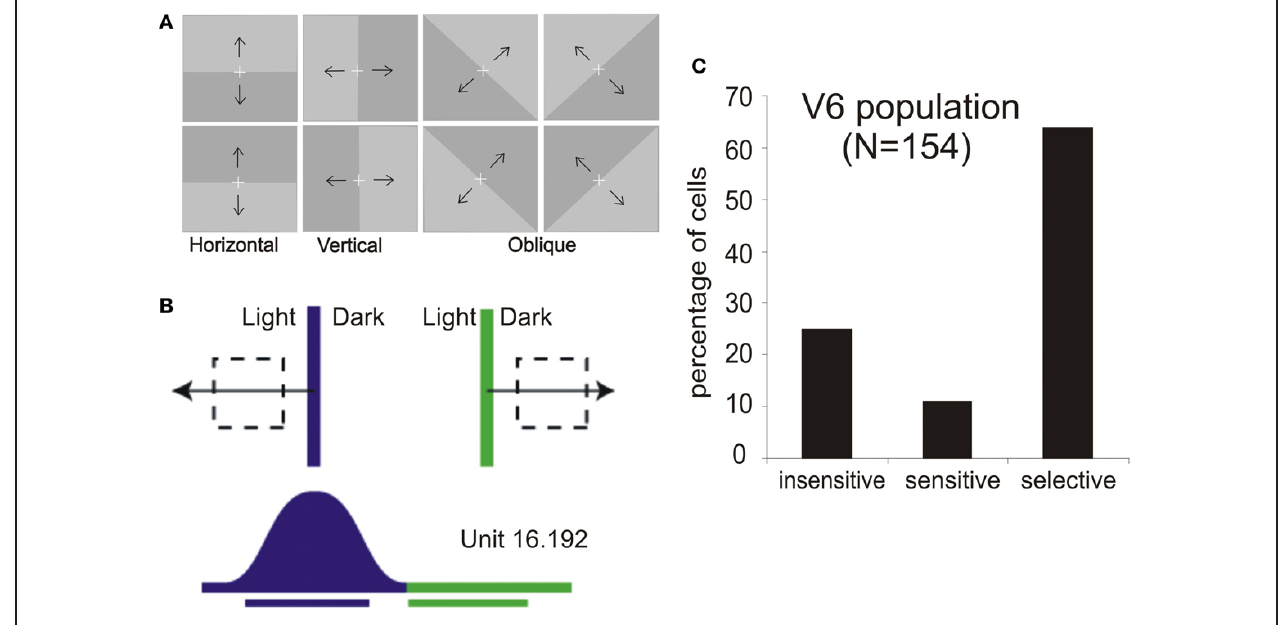
neural responses to the two directions of motion and bars indicating the durations of visual stimulations. (C) Incidence of direction sensitivity in V6 neuronal population. We defined as direction “selective” those cells whose response to a correctly oriented stimulus moving in the direction opposite to the preferred one was < 20% of the firing rate evoked during optimal stimulation; direction “sensitive” those whose response was between 20% and 80%; and direction “insensitive” those whose response in the opposite direction was > 80% of that in the preferred one. Modified from Pitzalis et al.